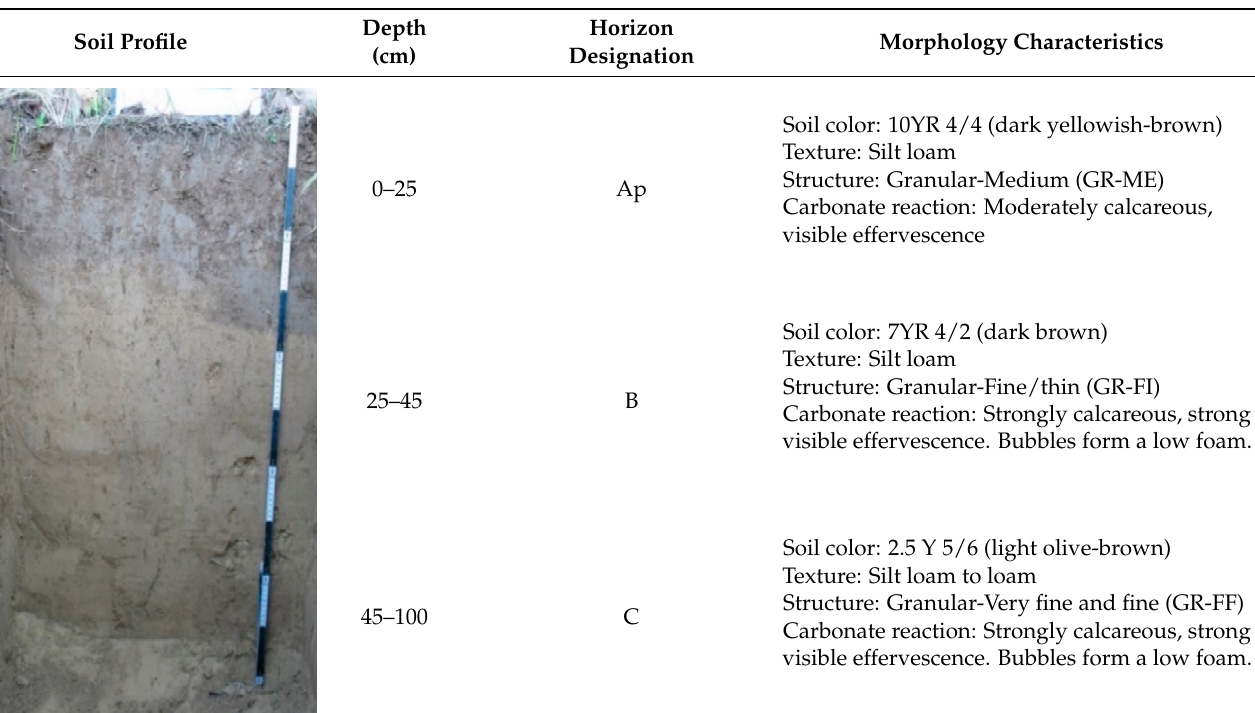
Table 3. Morphological features of the investigated soil